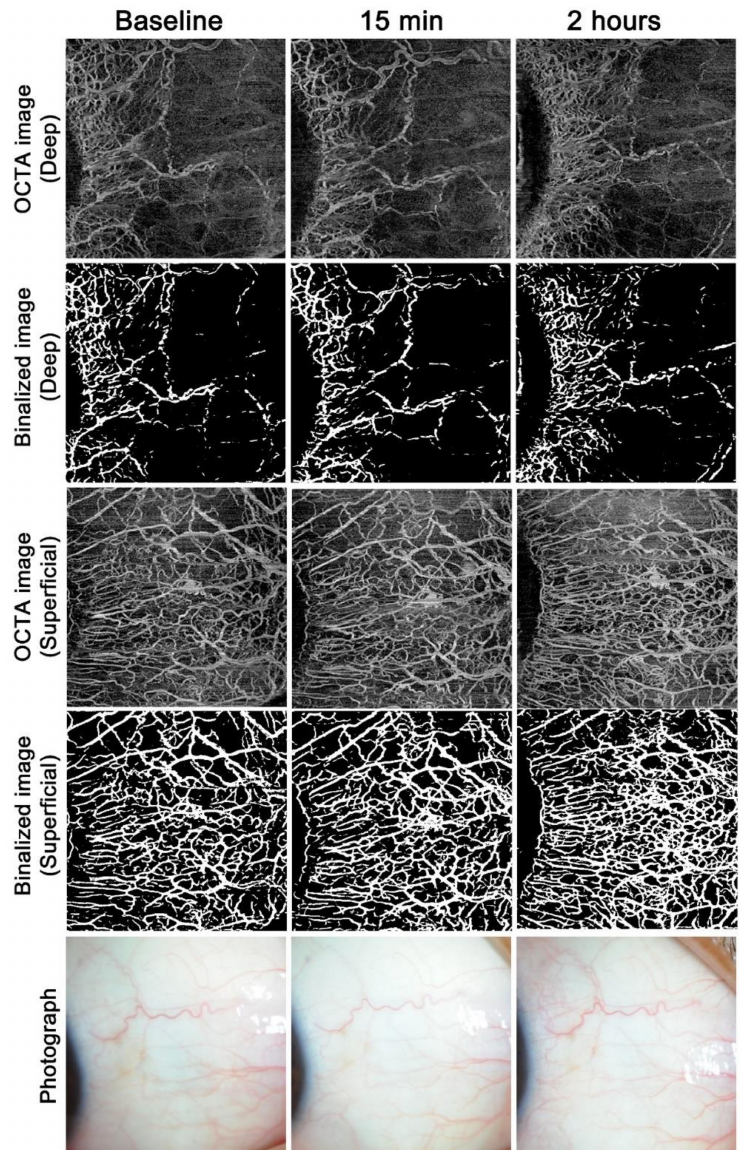
Figure 2. Time course of anterior-segment optical coherence tomography angiography findings and photographs after bimatoprost instillation. Example images in the nasal region of the right eye in a normal participant after a single instillation of